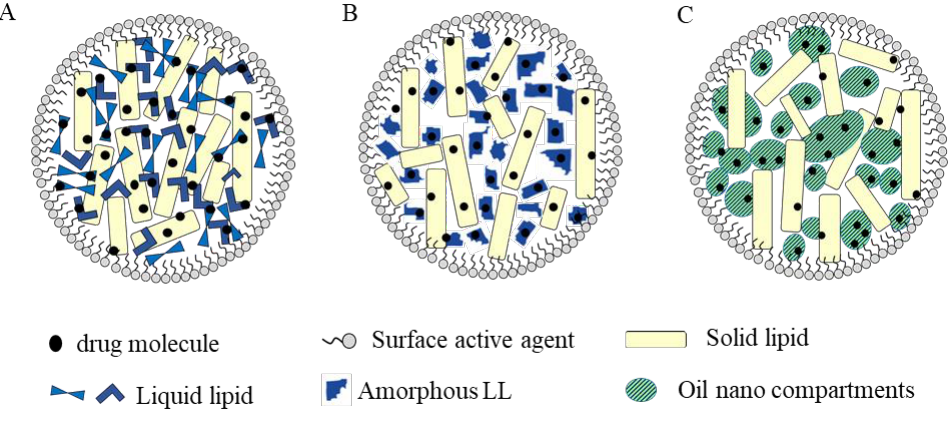
ff erent types of NLCs. ( A ) Imperfect; ( B ) amorphous; and ( C ) Figure 2. Different types of NLCs. ( A ) Imperfect; ( B ) amorphous; and ( C ) oil-in-fat-in-water. Figure 2. Di